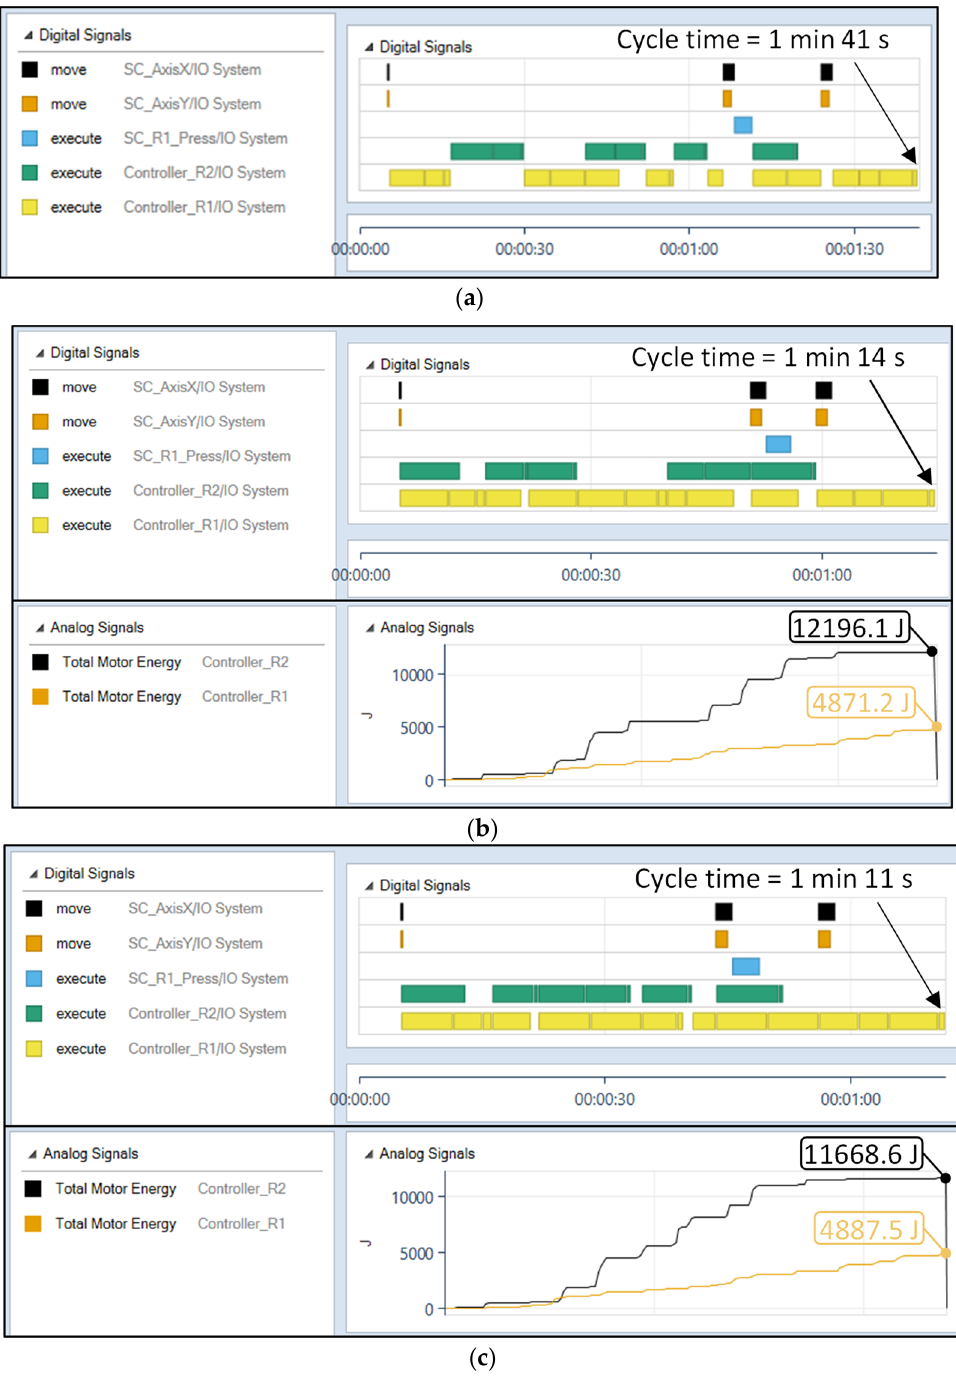
Figure 11. Results obtained by the VC approach. A better alternation of operations allows a reduction in the overall cell cycle time and energy consumption: ( a ) initial (sub-optimal) sequence; ( b ) improved sequence and ( c ) final (refined) sequence.